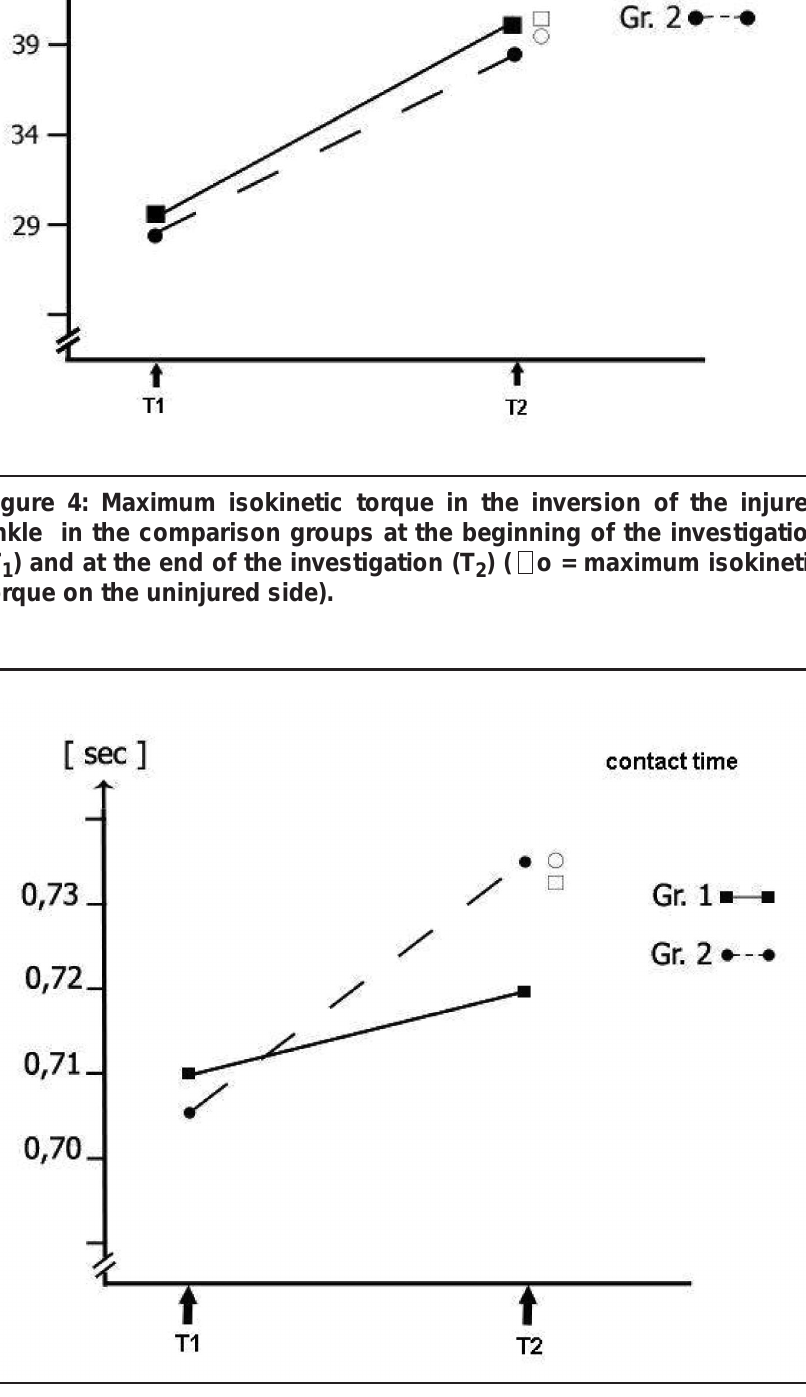
) 1 ) ( o = contact tine during gait on 2